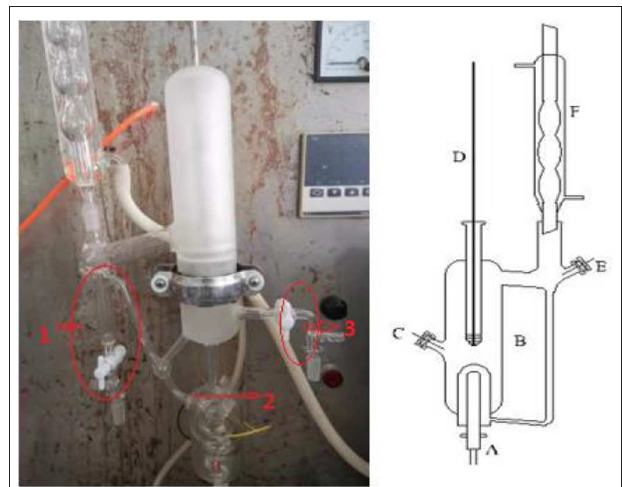
FIGURE 1 | Schematic diagram of the VLE apparatus used in this work: (1) vapor sampling port, (2) Sample level, (3) liquid sampling port, (A) heating mantle, (B) equilibrium still, (C) sampling port, (D) thermometer well, (E) sampling port, (F) condenser, REPRODUCED from the Wang et al.